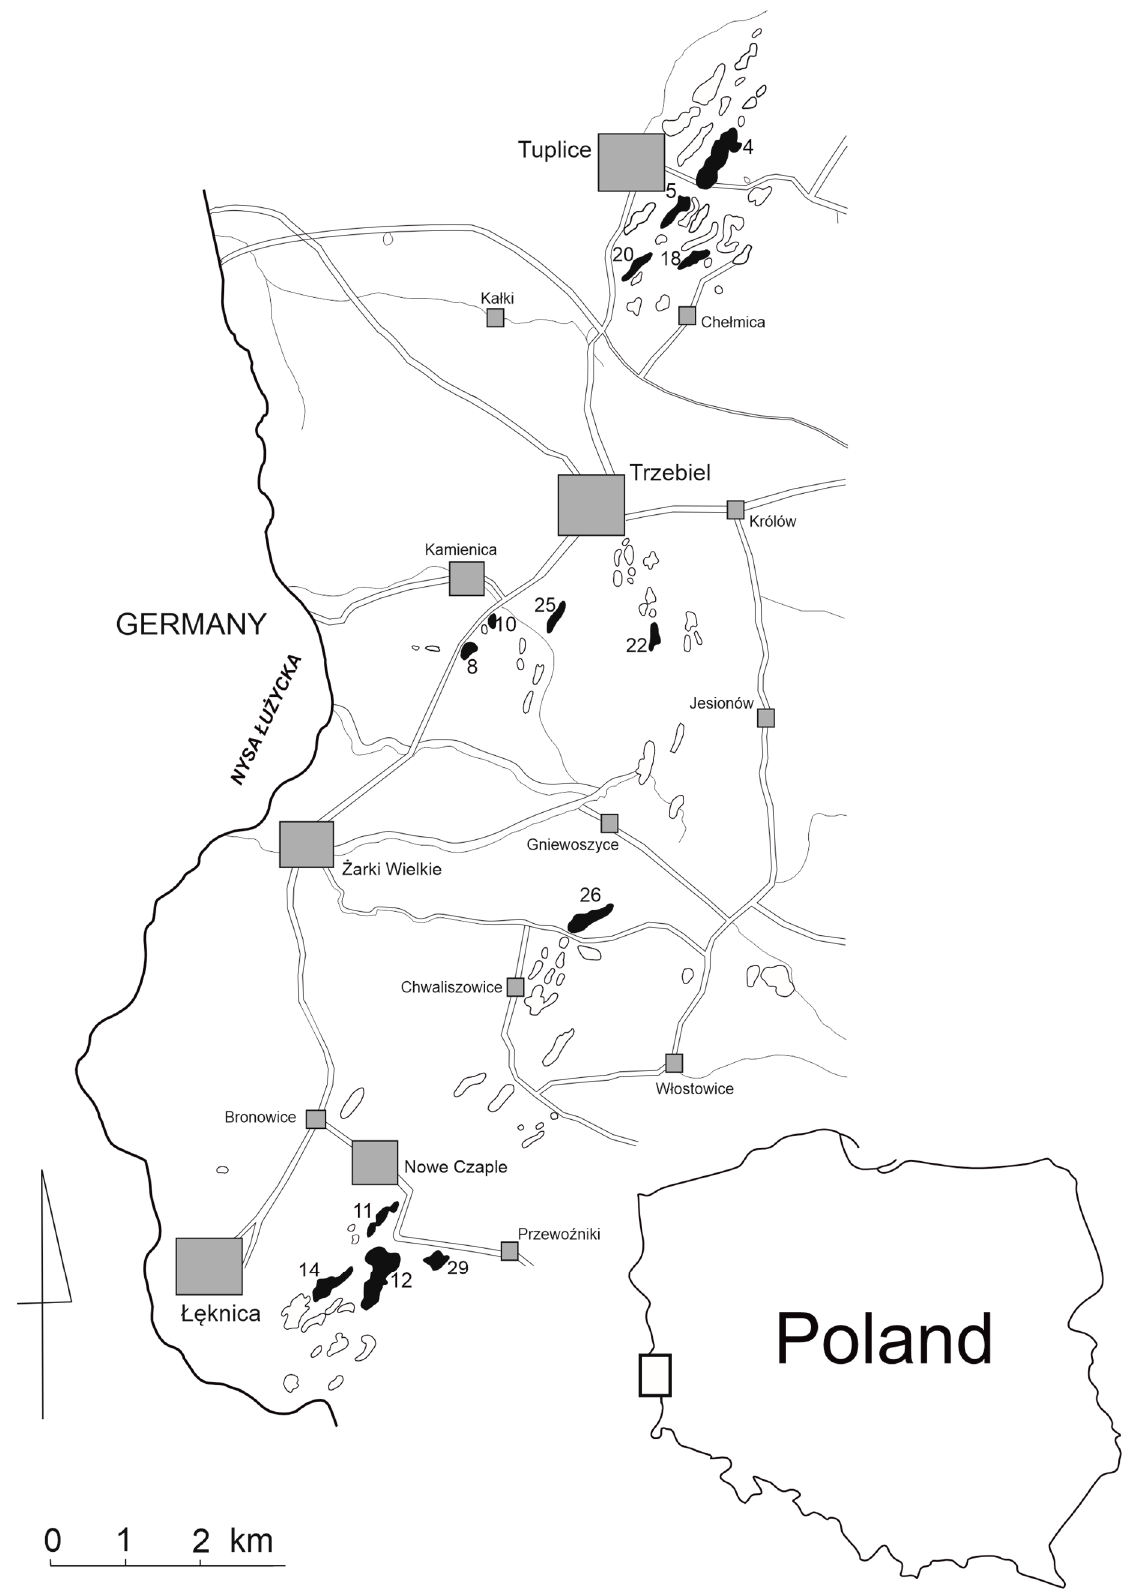
Figure 1. Location and spatial distribution of the investigated lakes (marked in black and numbered).